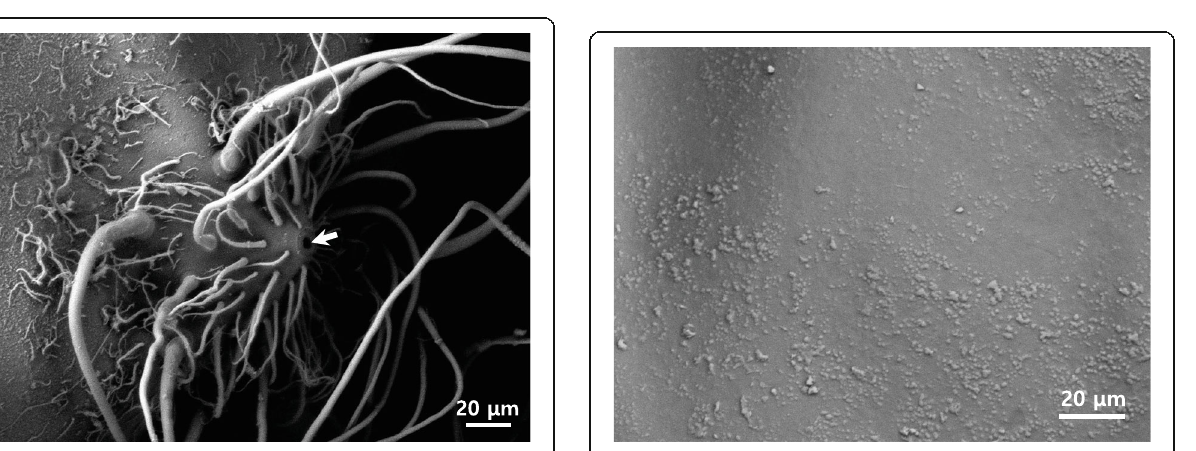
Fig. 3 Scanning electron micrograph of micropyle (arrow) on the fertilized egg envelopes from M. praecox . The micropyle was conical shaped with whippy adhesive filaments